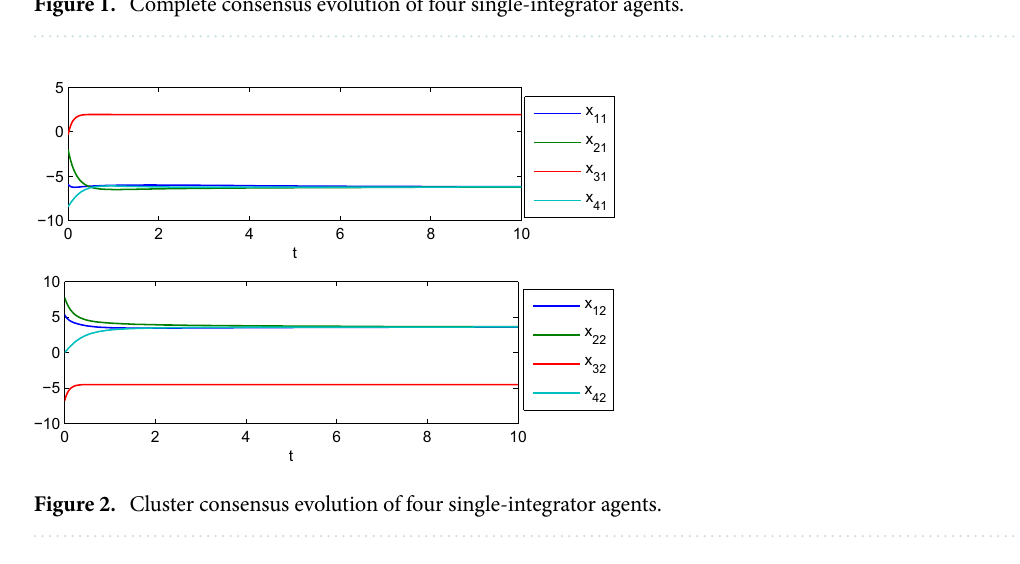
Figure 1. Complete consensus evolution of four single-integrator agents.